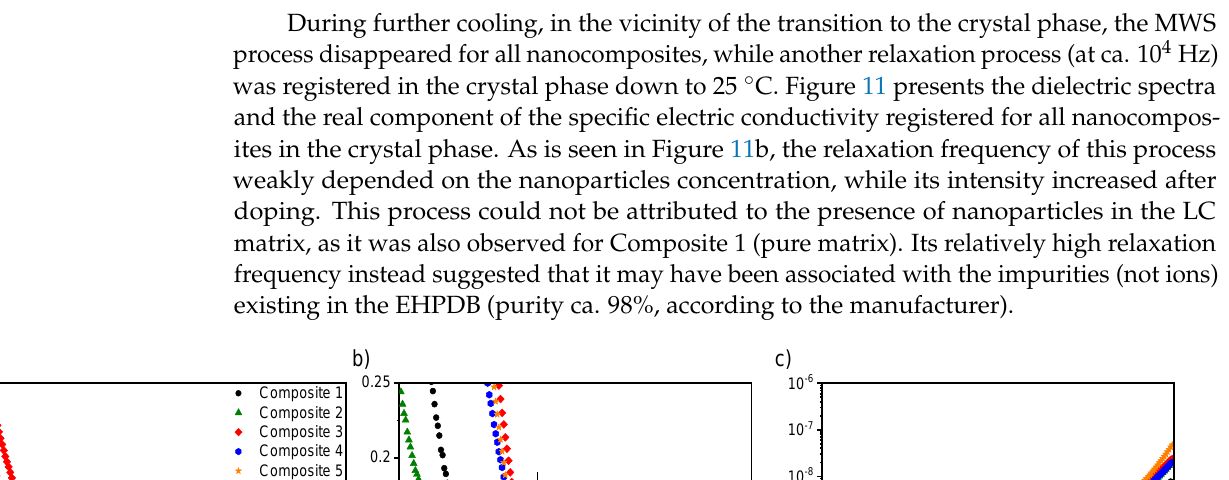
Figure 10. Temperature dependencies of the dielectric increment, ∆ ε ( a ), relaxation time ( b ) and relaxation time ( c ) of the Goldstone mode in nanocomposites. The legend in graph ( a ) is the same for all graphs. The vertical dashed lines represent the SmA* – SmC* phase transition temperature (during cooling).